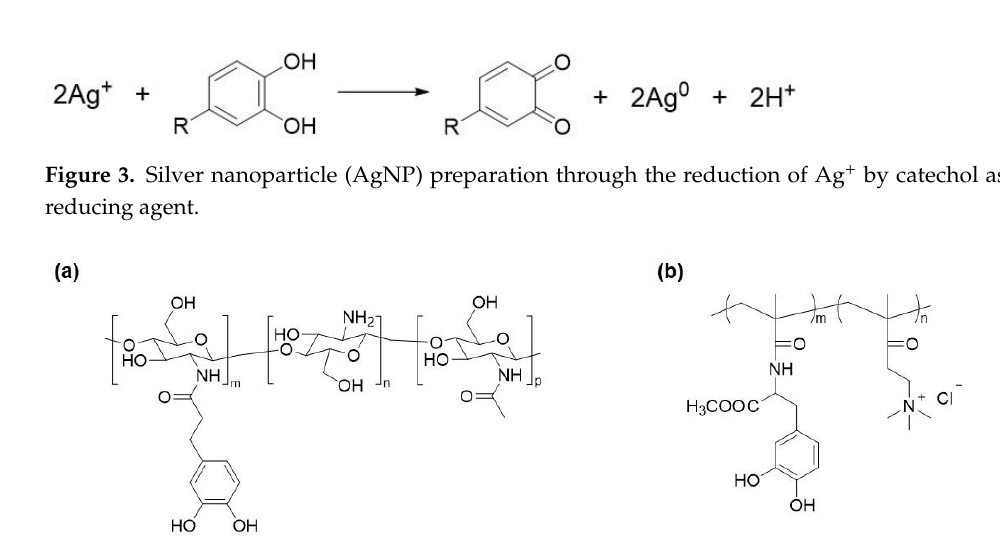
Figure 4. ( a ) Catechol-modified chitosan and ( b ) poly(mDOPA)- co -poly(DMAEMA + ).